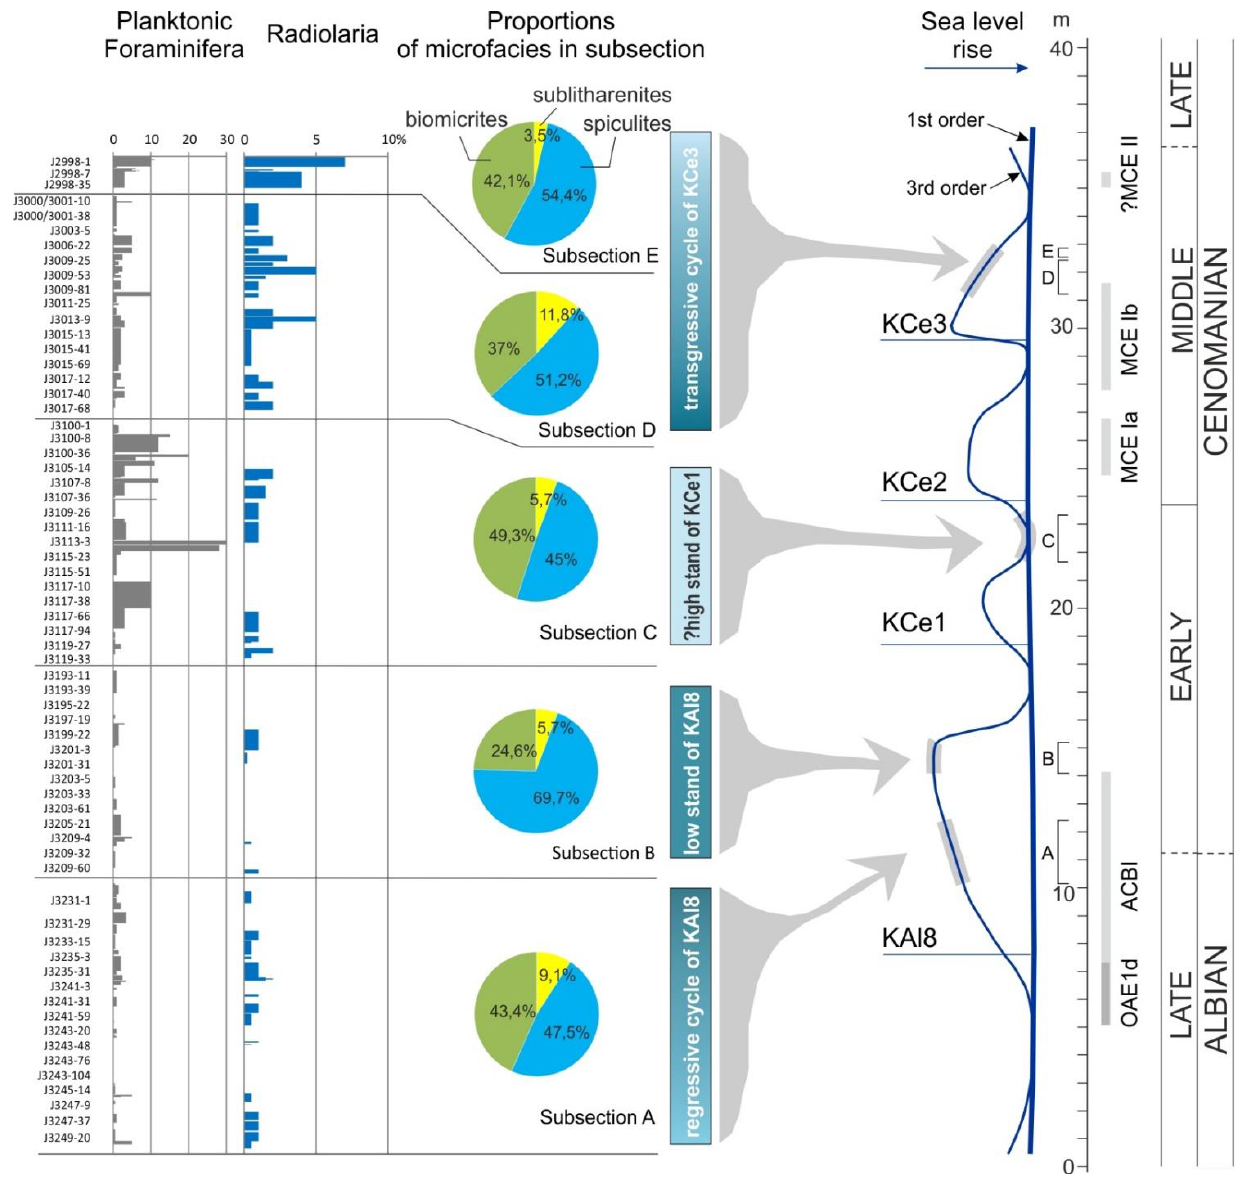
Figure 11. Changes in planktonic microfossils and other components of sandstones presented in the studied segments of the lower – middle Cenomanian sediments of the Silesian Nappe, Outer Carpathians in relation to eurybathic/eustatic cycles sensu Haq [1]. Note that the correlation of the section studied with the sea-level curve is presented after [32].